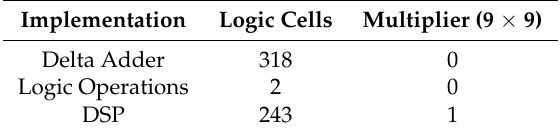
Table 8. Resource consumption of the implementations for multiplying on a FPGA.